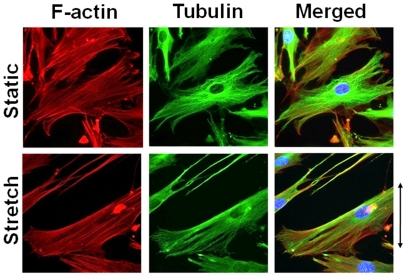
Fluorescent images of organization of F-actin and microtubules in the static or stretched cells.Cells were in the static condition (upper panels) or subjected to 2 h uniaxial cyclic stretch (lower panels). F-actin was visualized with rhodamine-phalloidin (red). Microtubules were visualized with FITC conjugated secondary antibody following immunostaining with anti-α-tubulin antibody (green). Cell nuclei were stained with DAPI (cyan).